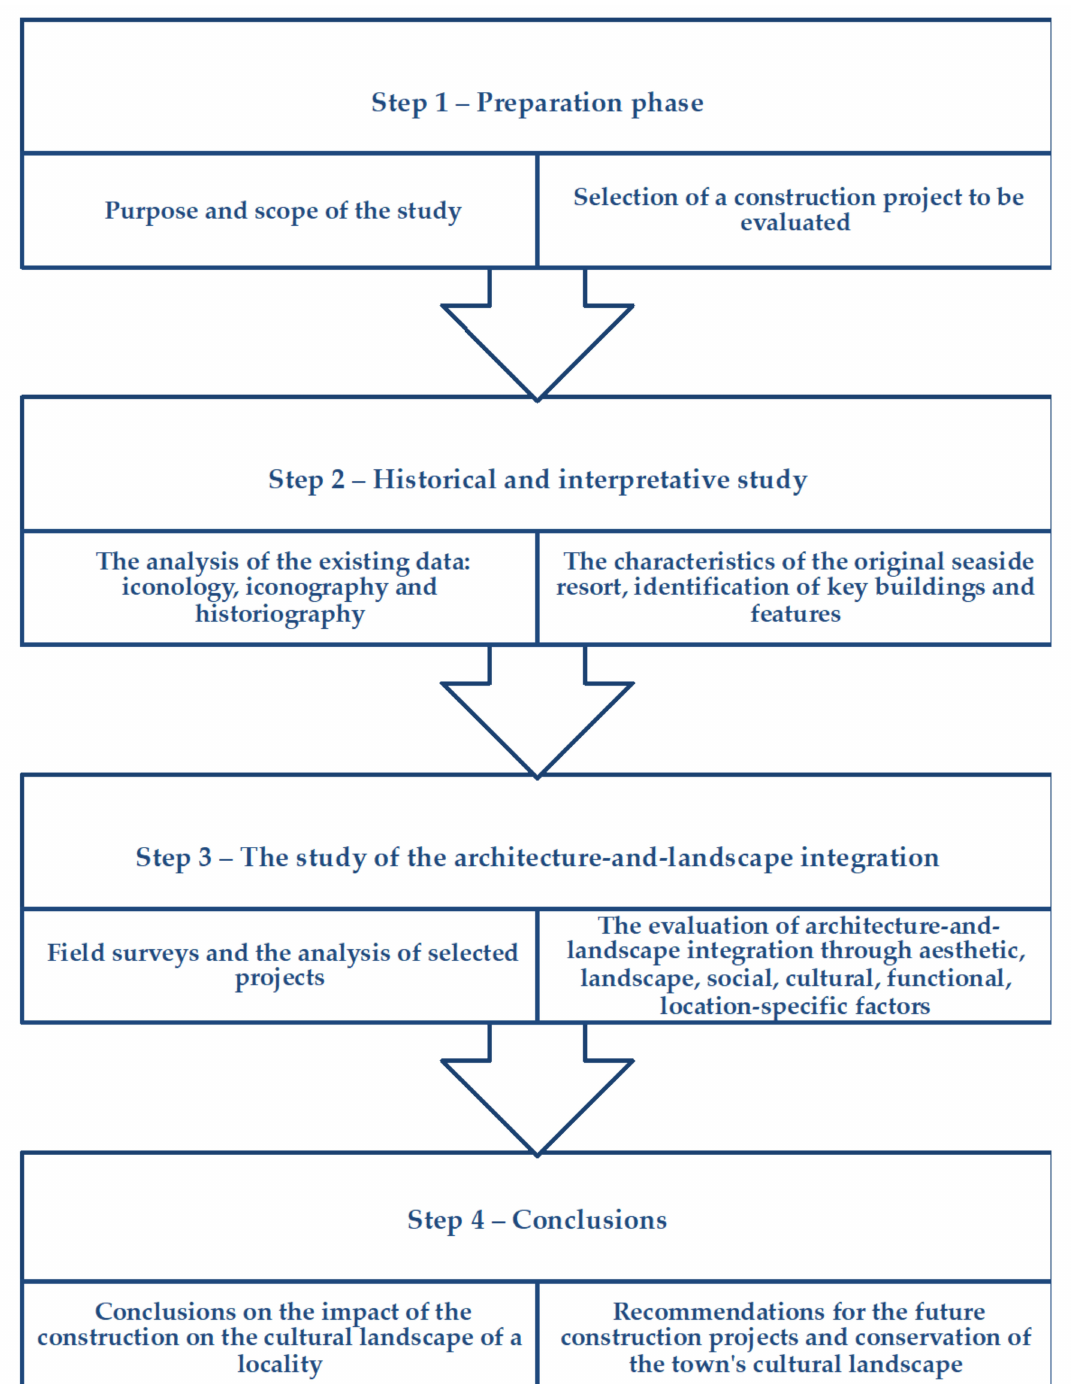
Figure 1. Study methodology diagram. Source: Authors’